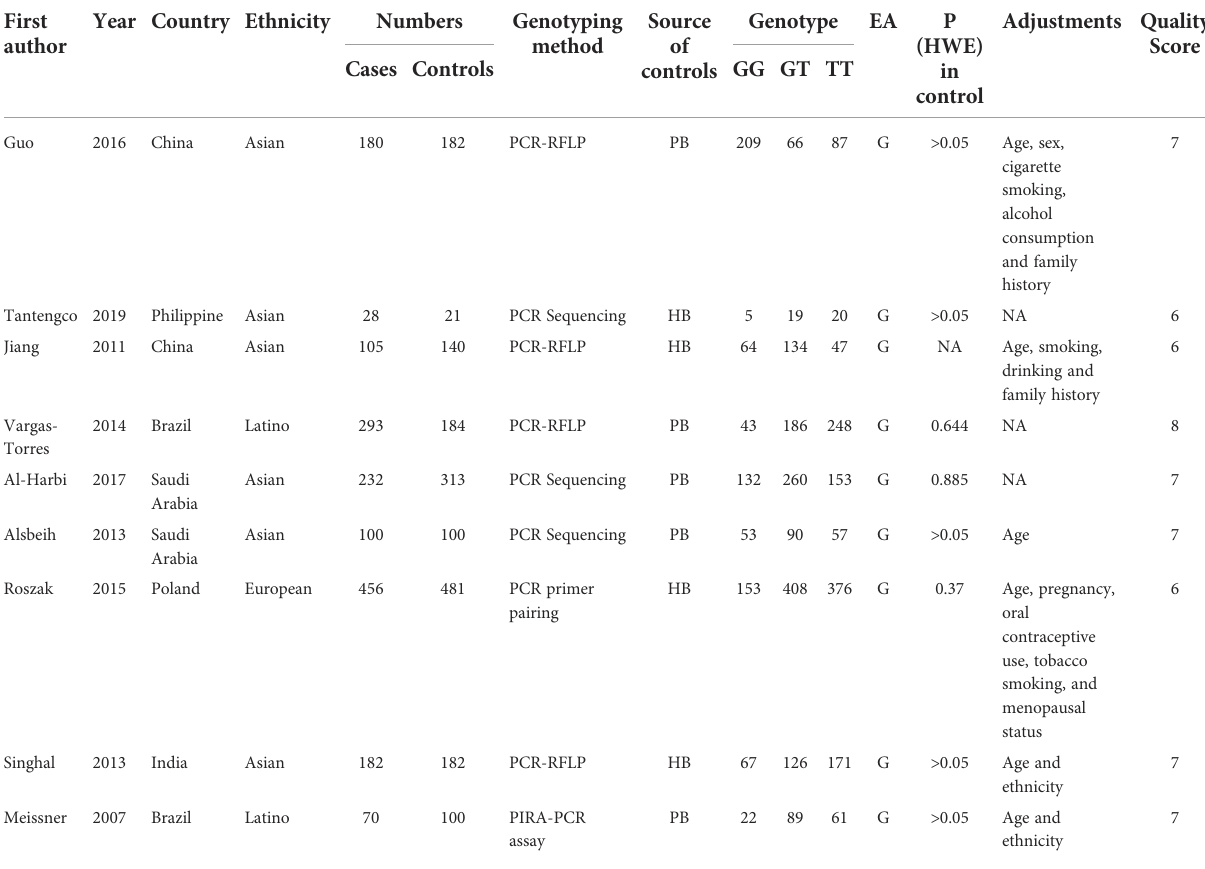
TABLE 1 Characteristics of the studies of MDM2 rs2279744 polymorphism included in the